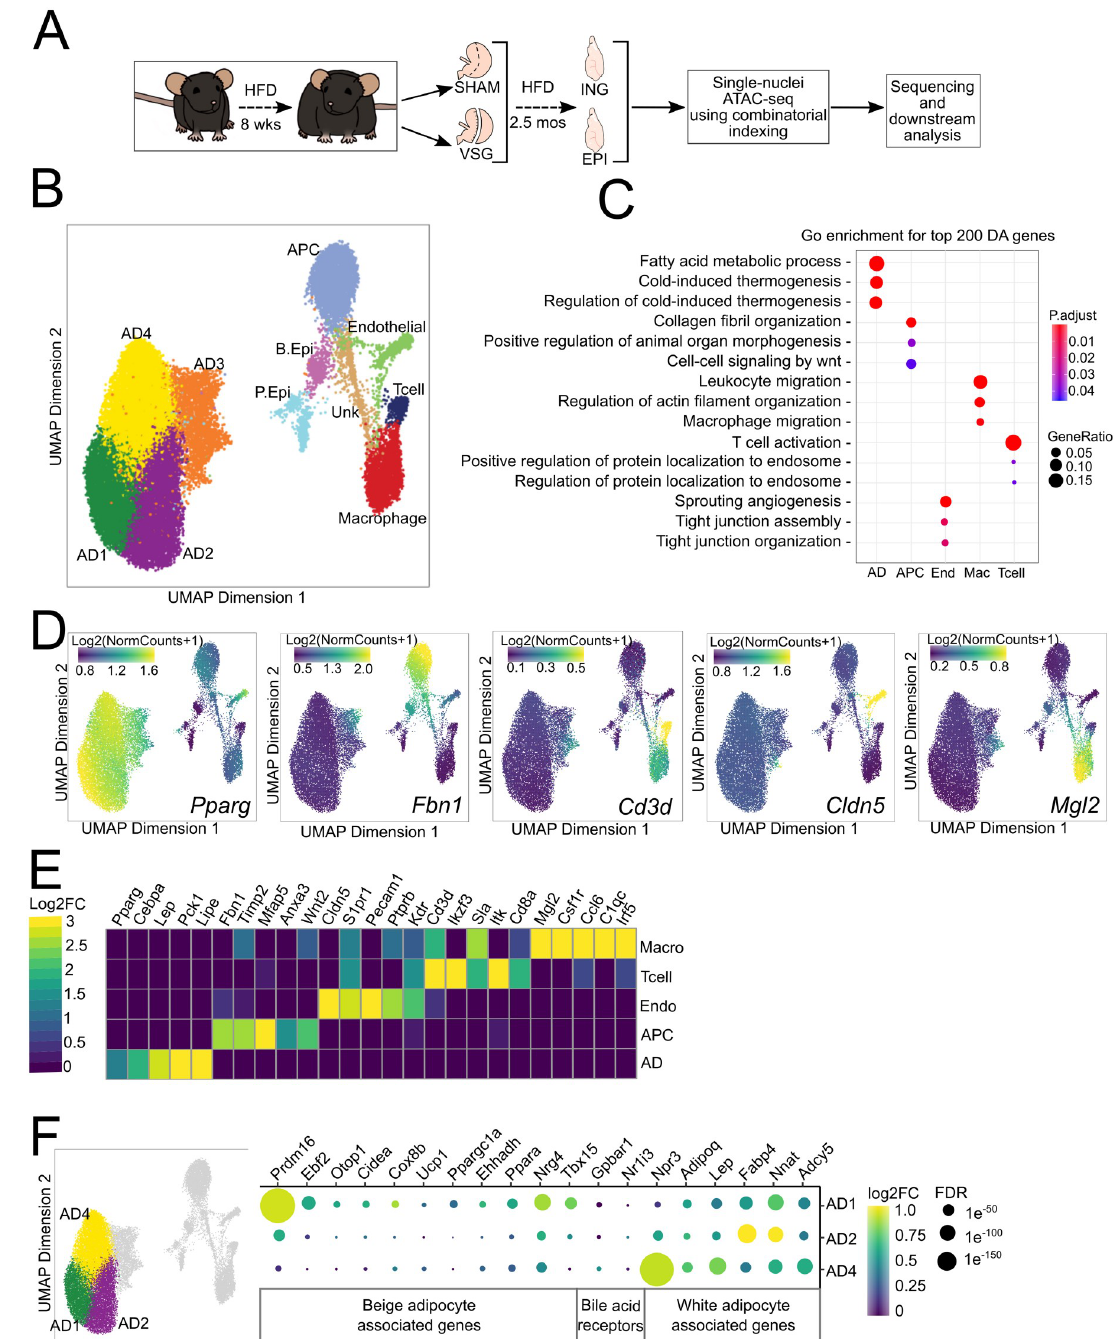
Fig 1. Clustering and cell type identification of cells in epididymal and inguinal adipose depots. https://doi.org/10.1371/journal.pone.0261783.g001 (End), identified as endothelial cells, had signatures of angiogenesis and tight junction enrich- ments and known marker genes Cldn5 , S1pr1 , Pecam1 , Ptprb , Kdr [18]. Two clusters of immune cells (Mac, Tcell) had distinct gene accessibility. In the first immune cluster, we found enrichment of the GO categories T-cell activation and protein localization to the